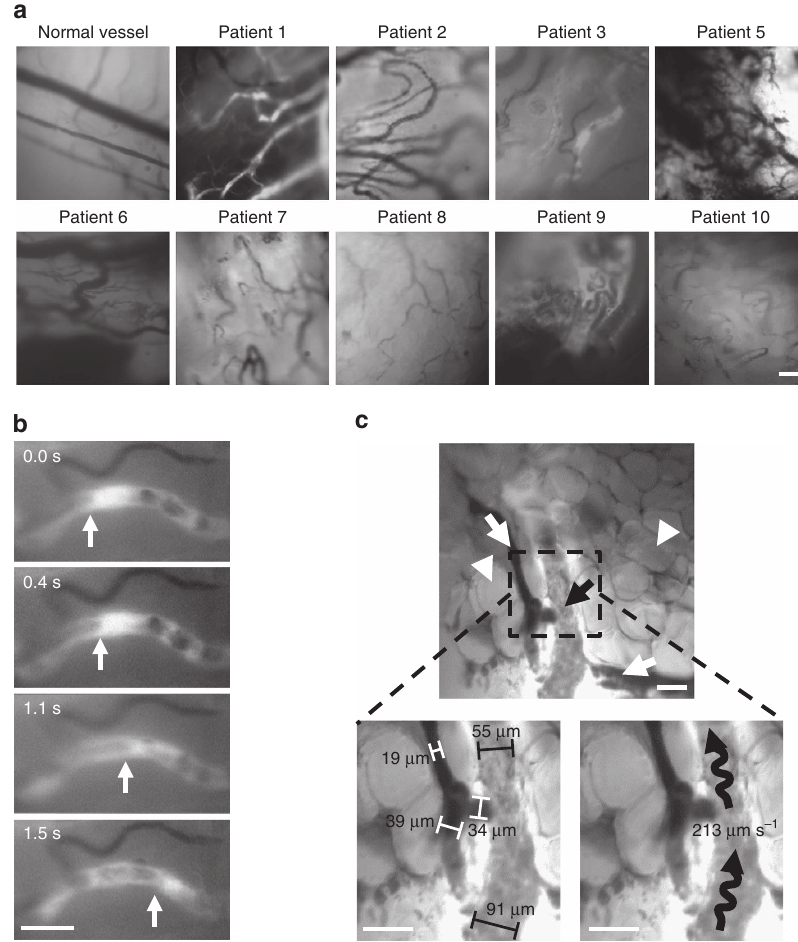
Figure 2 | Detection of blood flow in patient tumour microvasculature. ( a ) Representative photomicrographs of tumour microvasculature in patients following fluorescein injection. ( b , c ) Photomicrographs exported during movie analysis of blood flow velocity. ( b ) Arrow denotes the trailing edge of a bright fluorescein signal that was utilized to determine blood flow velocity in mms (cid:3) 1 . ( c ) Measurement of tumour diameters and blood vessel flow rate. White arrows indicate vessels that did not support blood flow during observation, black arrows denote functional vessels and white arrowheads show adipocytes. Brackets depict tumour diameter measurements of non-functional (white) and functional (black) vessels with wavy black lines demonstrating direction of blood flow and flow rate. ( a – c ) Bar is 100 m m.